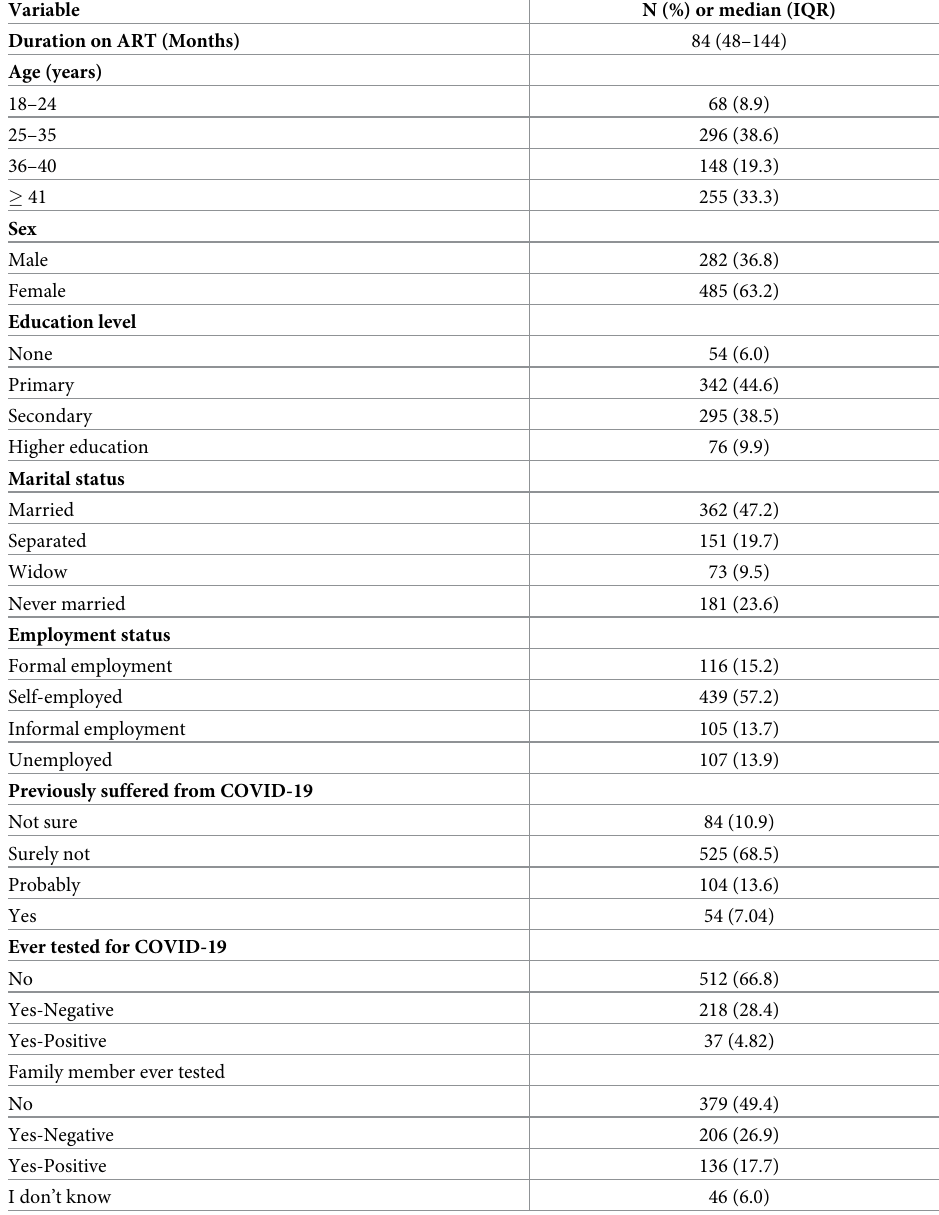
Table 1. Respondent characteristics (N =